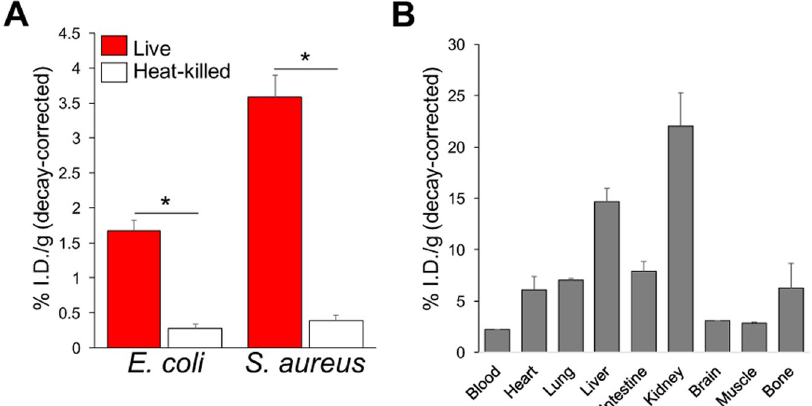
Figure 5. Ex vivo analysis of both infected and normal mice, obtained via tissue harvesting and gamma- counting. In all cases mice injected intravenously with [ 11 C] D-Met were sacrificed at 70 minutes. ( A ) Analysis of harvested deltoid muscles, performed immediately following the imaging studies described in this manuscript. The deltoid muscles corresponding to inoculation with live bacteria were compared with the contralateral side (heat-killed). ( B ) The biodistribution of [ 11 C] D-Met was also studied in a separate cohort of normal CBA/J female mice. The highest accumulation was observed in the kidneys and liver, similar to previously reported findings for [ 11 C] L-Met 34 .